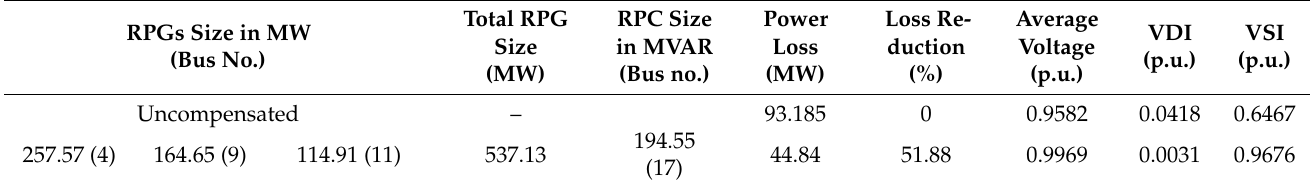
Table 6. Combination of RPC and RPGs at UPF.